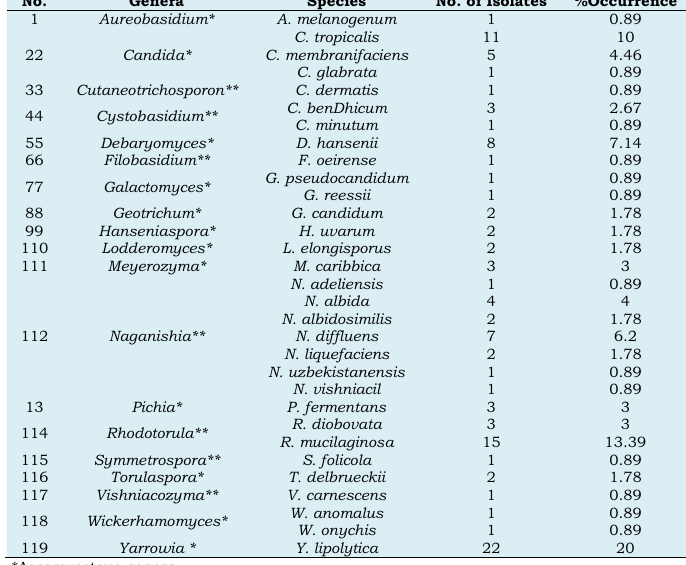
Table 3 Species of ascomycetous and basidiomycetous yeasts with percentage of occurrence